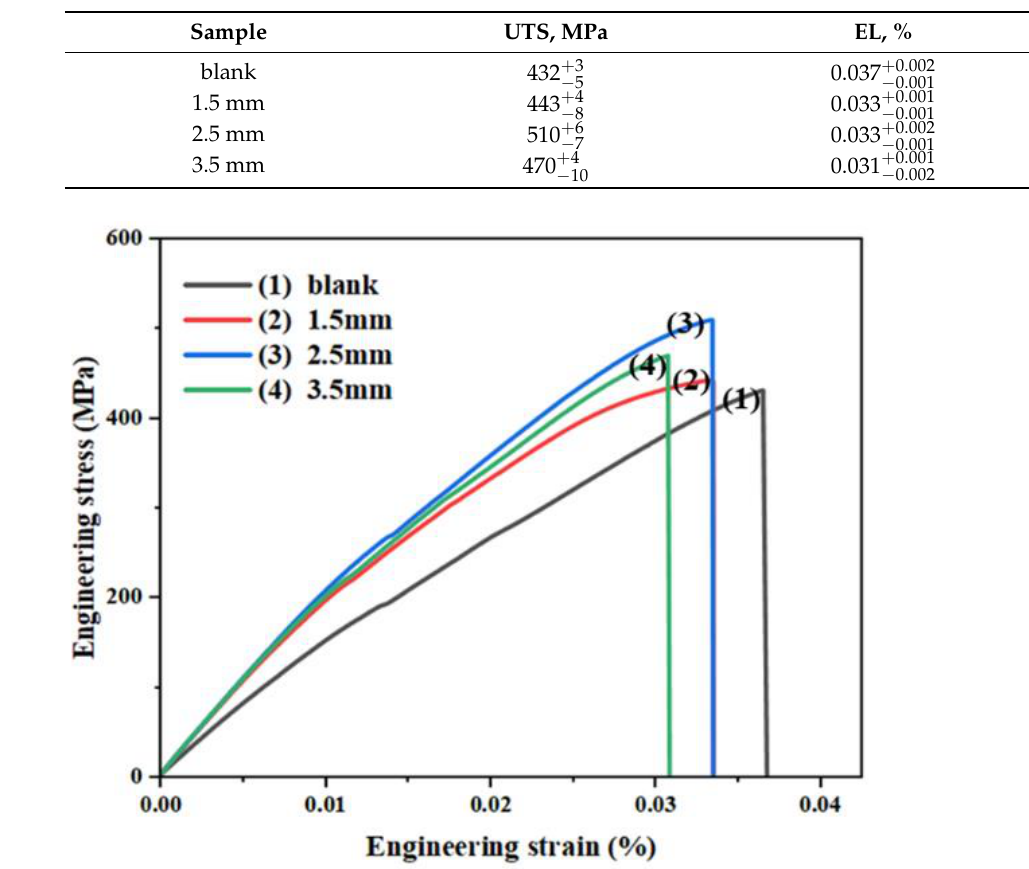
Figure 10. Tensile stress – strain curves of different samples. Table 2. Tensile property test results with different unit spacings.